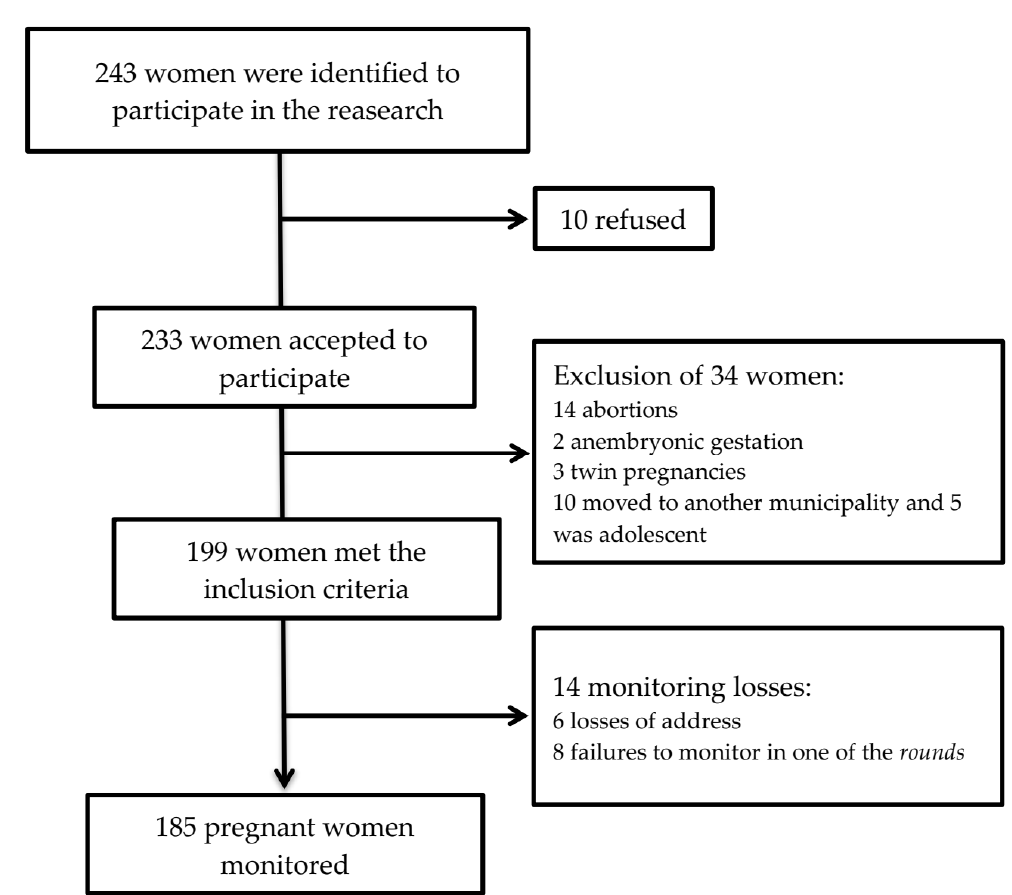
Figure 1. Monitoring flowchart of pregnant women. Cohort NISAMI. Santo Antônio de Jesus, Bahia, April 2012 and June 2013.